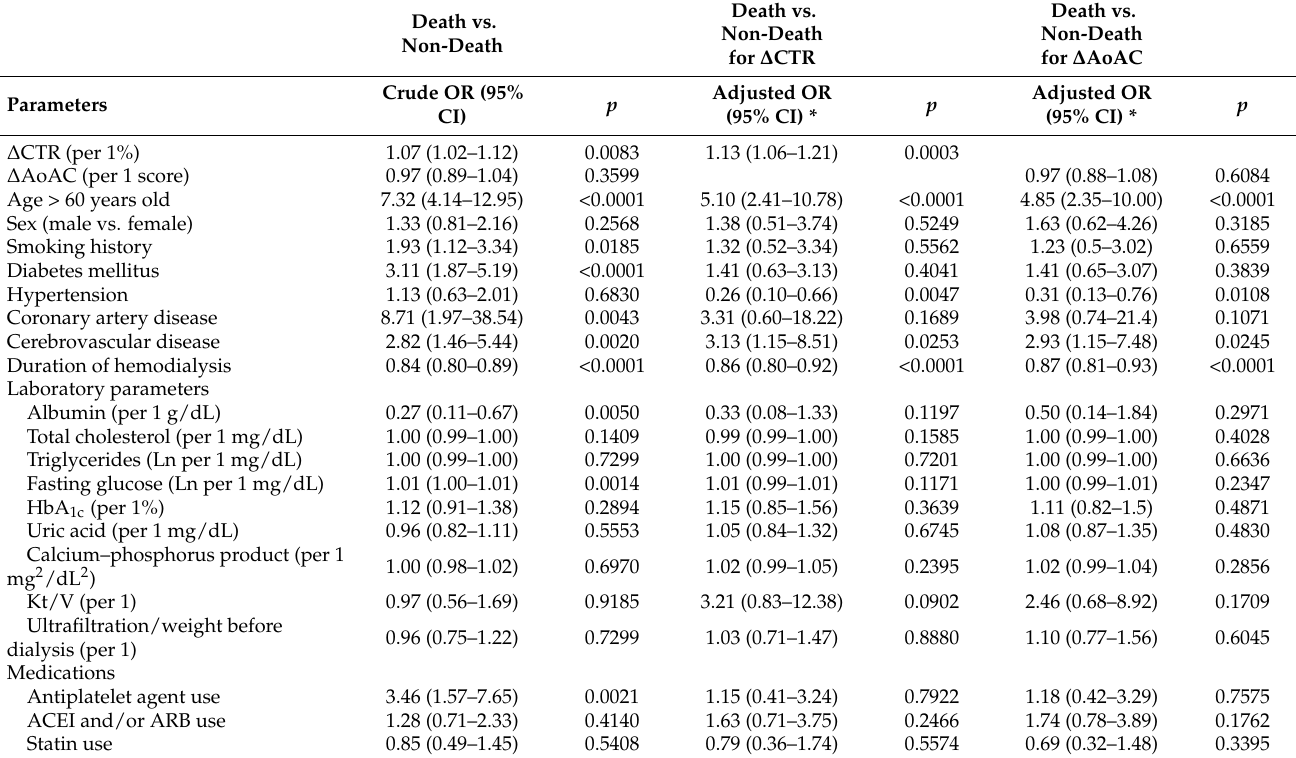
Table 8. Association of Δ CTR and Δ AoAC with overall mortality.